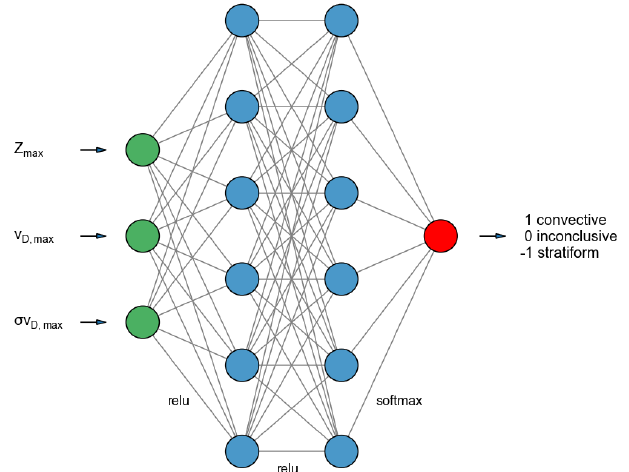
Figure 6. Diagram of the neural network with an input layer con- sisting of three nodes (green) according to the three MRR-based variables, two hidden layers with six nodes each (blue) and the out- put layer with one node